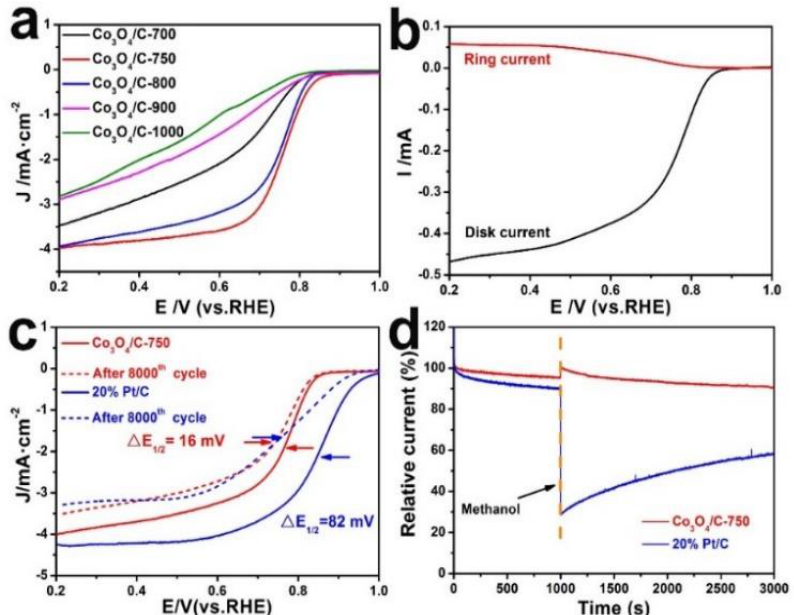
Figure 4. ( a ) LSV curves of Co 3 O 4 /C−700, Co 3 O 4 /C−750, Co 3 O 4 /C−800, Co 3 O 4 /C−900 and Co 3 O 4 /C−1000. ( b ) RRDE LSV curves for Co 3 O 4 /C−750, with GC disk−Pt ring electrodes at 1600 rpm